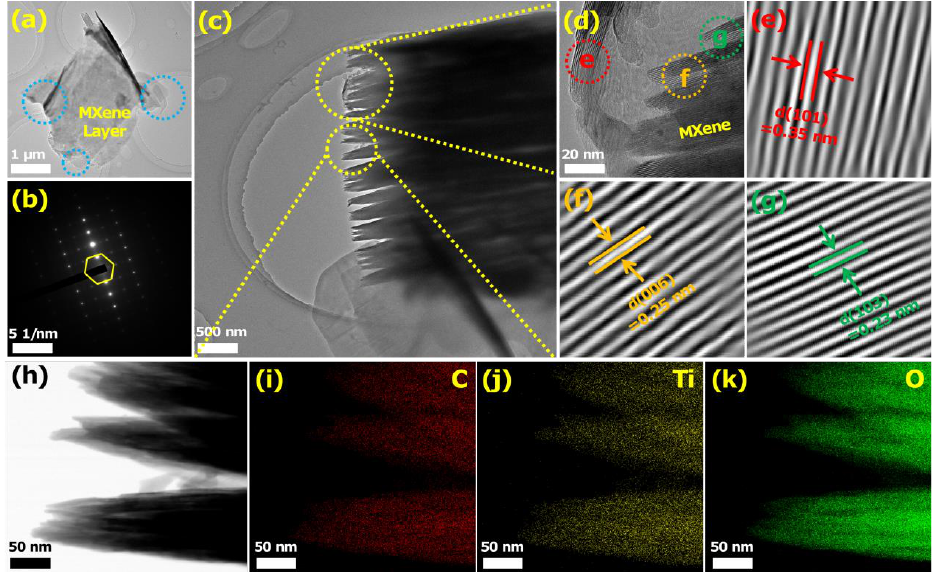
Figure 3. ( a ) TEM of MXene and ( b ) the corresponding SAED patterns. ( c ) TEM of MXene, ( d ) the corresponding HRTEM images, and the selected area ( e – g ) spacing images of ( e ) (101) plane, ( f ) (006) plane, and ( g ) (103) plane of MXene. ( h ) Bright-field scanning TEM image and EDX elemental mapping of the ( i ) C, ( j ) Ti, and ( k )